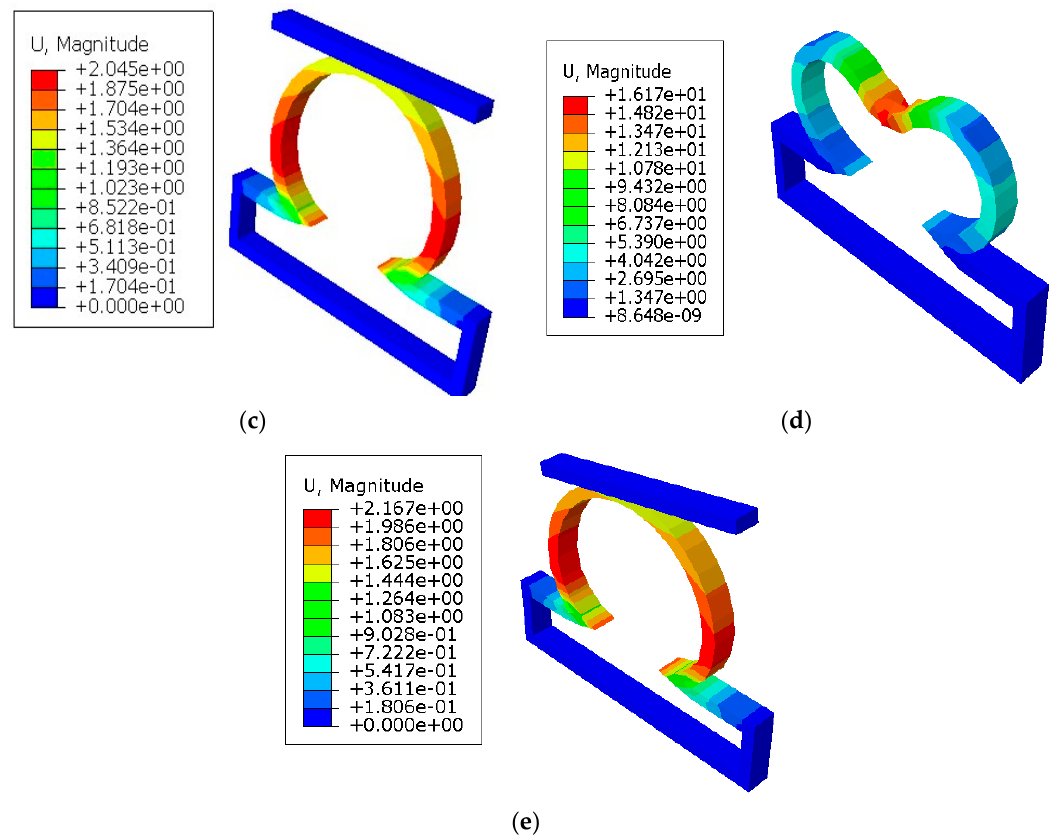
Figure 4. Finite element simulations of displacement (mm) on axisymmetric intracranial saccular aneurysm for the cases where ( a ) lesions without constraints; ( b ) lesions with short contact constraints (20 mm); ( c ) lesions with long contact constraints (40 mm); ( d ) lesions with point load on the fundus; and ( e ) lesions with long contact constraints at an angle of 10 degrees from the horizontal axis. The associated stress results for all lesions were performed under the applied uniform pressure of P = 120 mmHg.